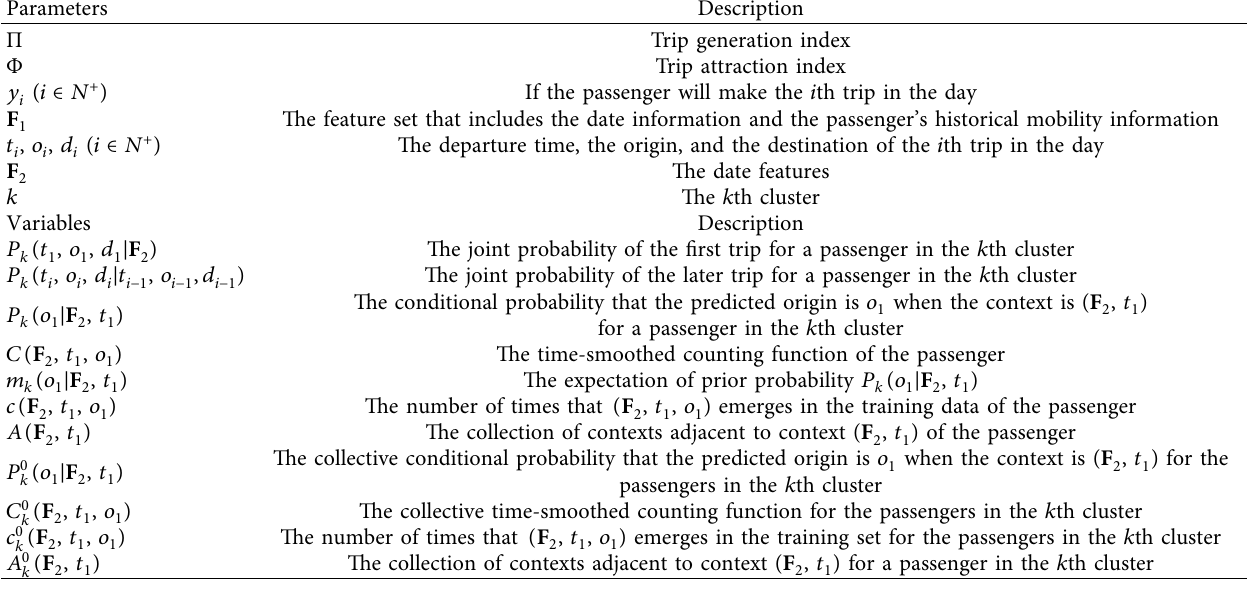
Table 1: Parameter and variable